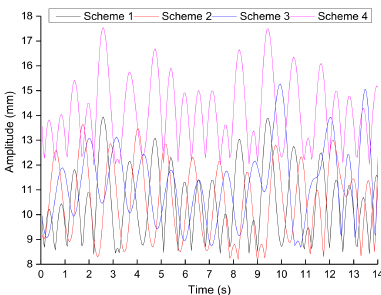
Figure 15. Amplitude change when h = 5 cm and no heaving plate is installed.